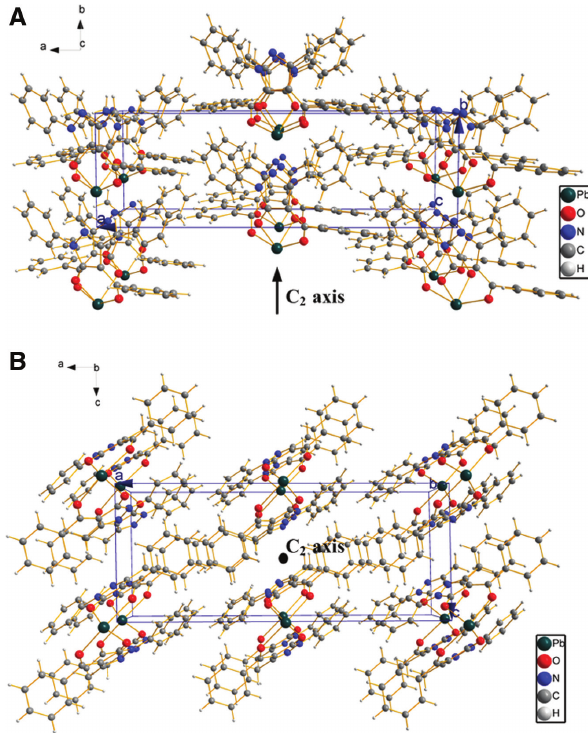
Figure 1 Projection of the unit cell packing of the complex onto the (A) ab plane and (B) ac plane to illustrate the polar packing along the C axis. 2 four O atoms from two deprotonated HPMBP ligands with